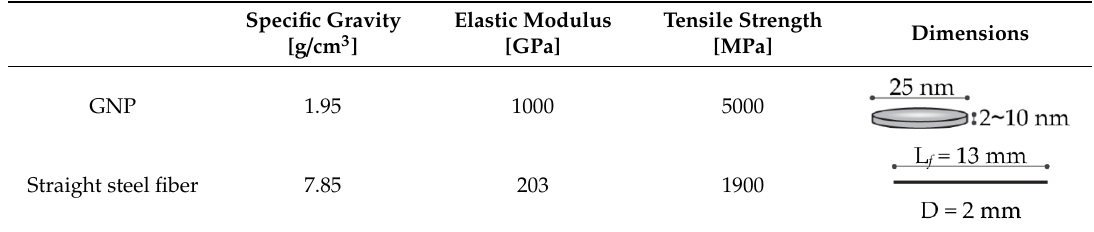
Table 1. Mechanical and physical properties of the GNP and steel fiber reinforcement (taken from [33]).